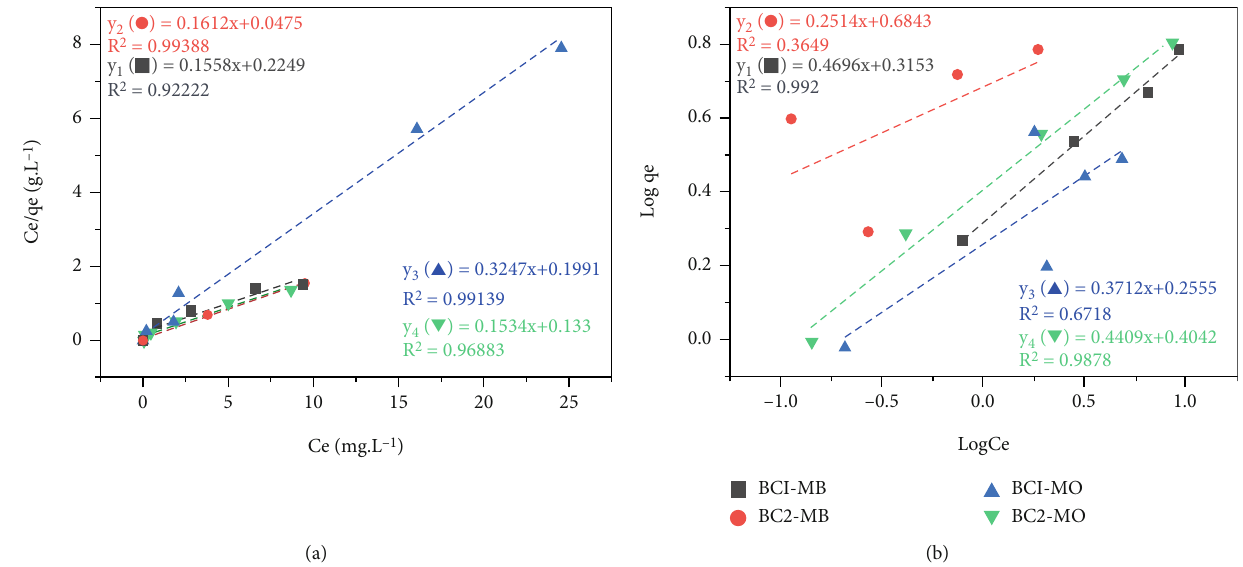
Figure 16: Langmuir (a) and Freundlich (b) adsorption isotherm model fi ttings for the adsorption of MB and MO on BC1 and BC2 at 25 ° C. Table 4: The adsorption isotherm of MO and MB adsorbed on BC2 and BC2 materials according to Langmuir and Freundlich